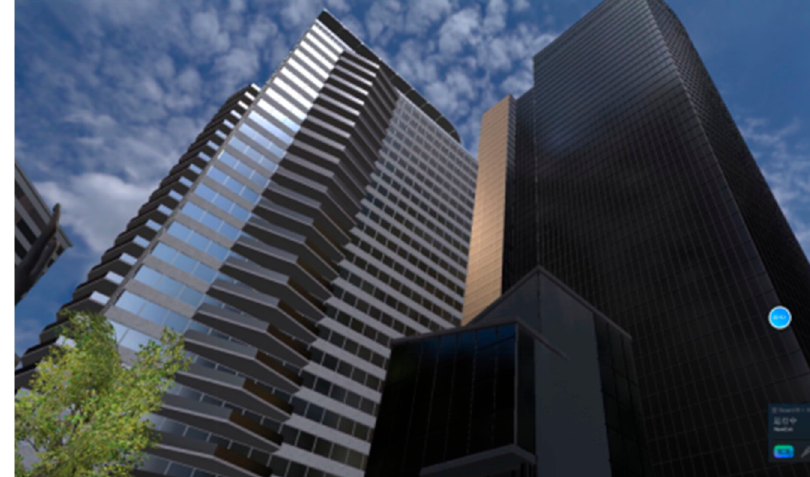
Figure 4. Screenshot 1 of an urban scene.